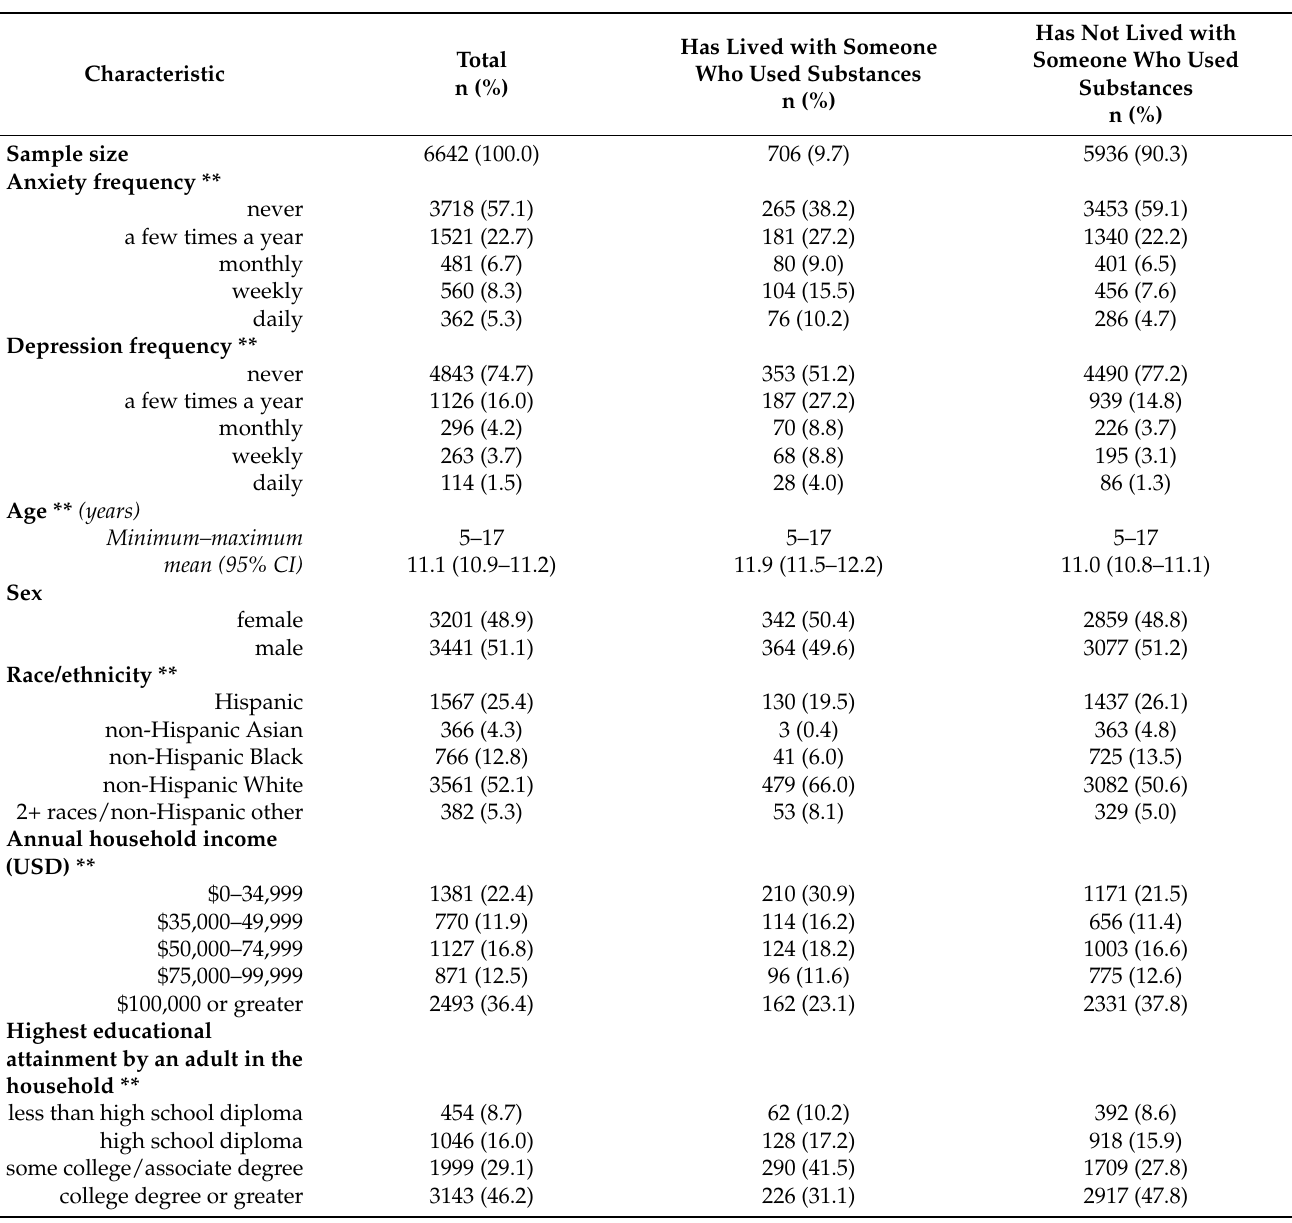
Table 2. Descriptive characteristics of the sample children—2019 National Health Interview Survey (n = 6642) *.